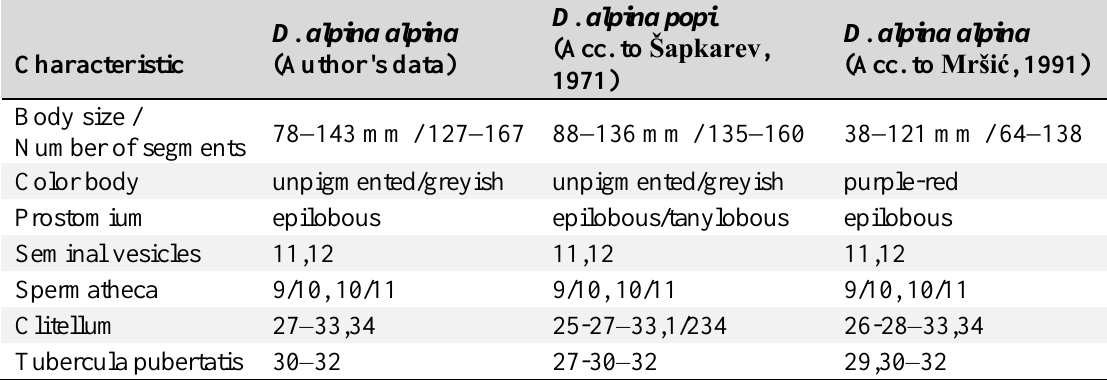
Table 2. A comparison of some taxonomical characteristics of the subspecies Dendrobaena alpina alpina and D . alpina popi